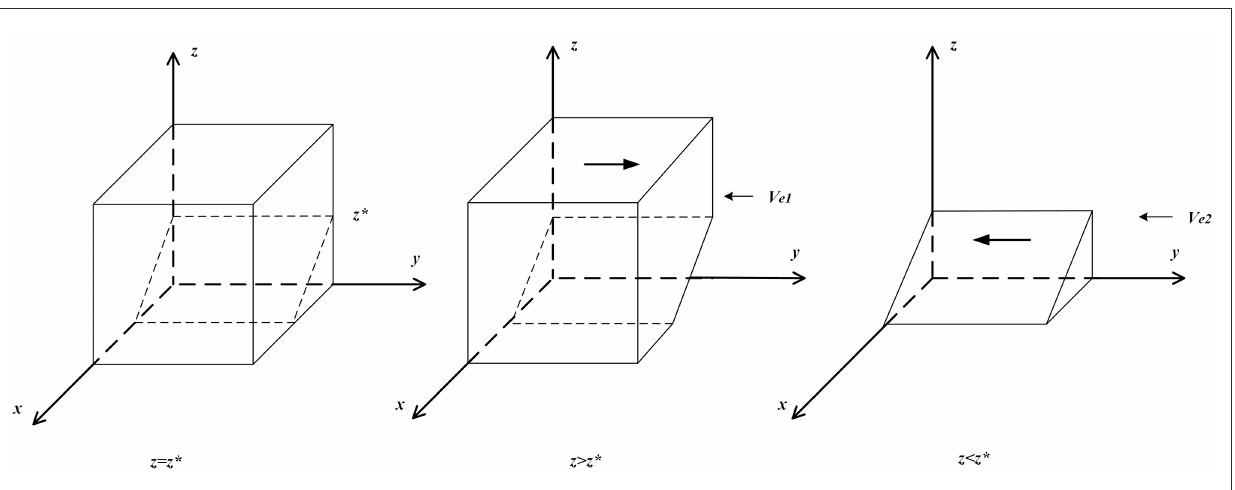
FIGURE2 Phase diagram of clients’